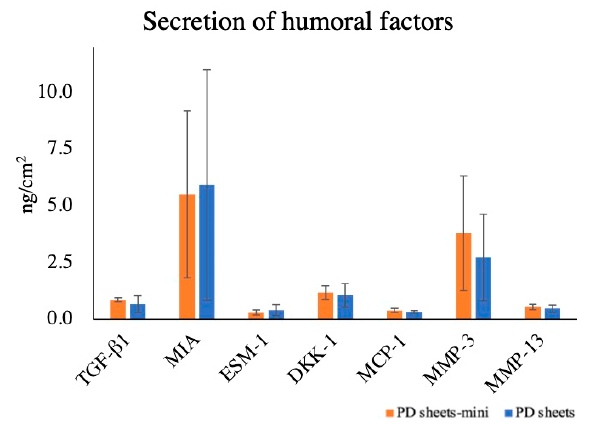
Figure 4. Amounts of secreted humoral factors. The amounts of transforming growth factor beta-1 (TGF- β 1), melanoma inhibitory activity (MIA), endothelial cell-specific marker 1 (ESM-1), Dickkopf-1 protein (DKK-1), monocyte chemoattractant protein 1 (MCP-1), matrix metalloproteinase (MMP)-3, and MMP-13, humoral factors related to cartilage, did not differ significantly between mini PD sheets and PD sheets.